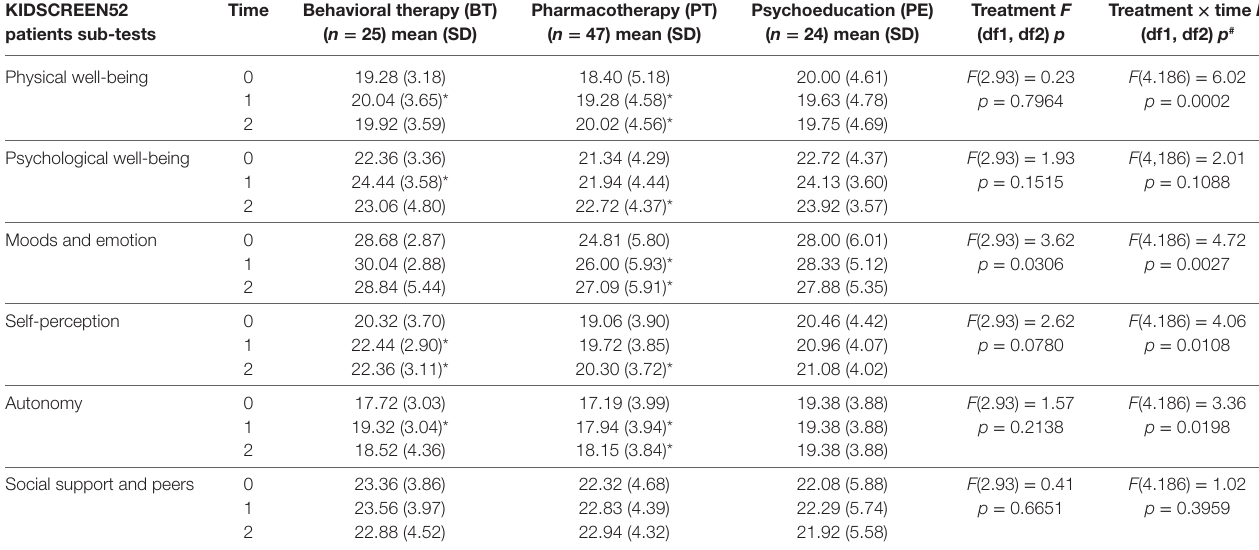
TaBle 4 | KIDSCREEN-52 (patients) outcome (values are expressed as absolute